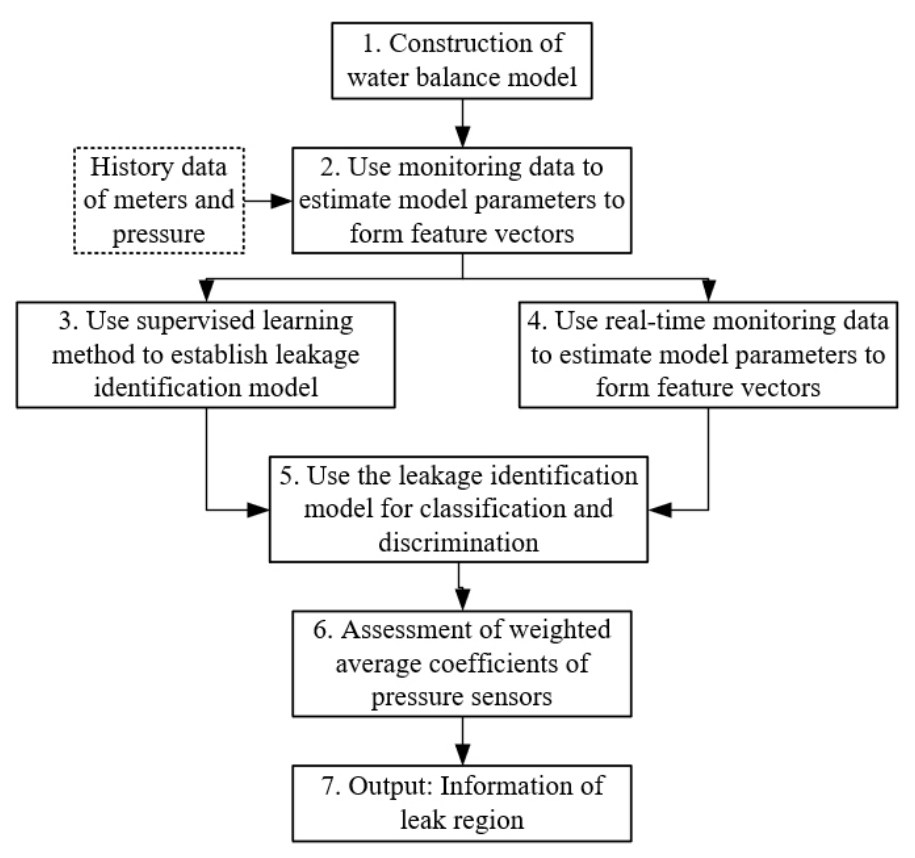
Figure 1. Framework of the proposed